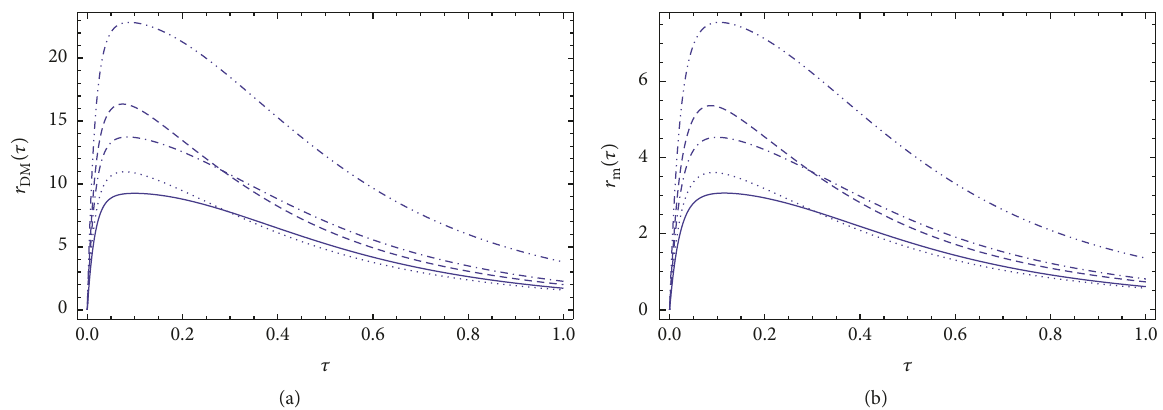
Figure 7: Time variation of the dark matter energy density (a) and of the radiation (b) during the reheating period in the presence of a Higgs type scalar field potential, for different values 𝛼 𝜙 of the decay width of the scalar field: 𝛼 𝜙 = 1.00 (solid curve), 𝛼 𝜙 = 1.20 (dotted curve), 𝛼 = 1.40 (dash dotted curve), 𝛼 = 1.60 (dashed curve), and 𝛼 = 2.50 (dash double dotted curve), respectively. For the potential parameters 𝜙 𝜙 𝜙 𝜇 and ] we have adopted the values 𝜇 = 2 and ] = 3 , respectively. The initial conditions used to numerically integrate (105) are 𝜙(0) = 10.5 , 𝑢(0) = −0.05 , 𝑁 (0) = 100 , 𝑟 (0) = 0 , and 𝑟 (0) = 0 , respectively. 𝜙 DM m